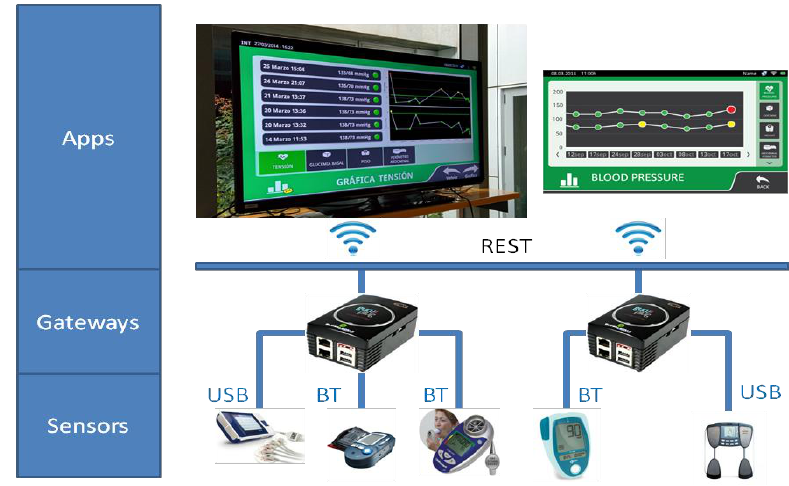
Figure 13. Demonstrating application